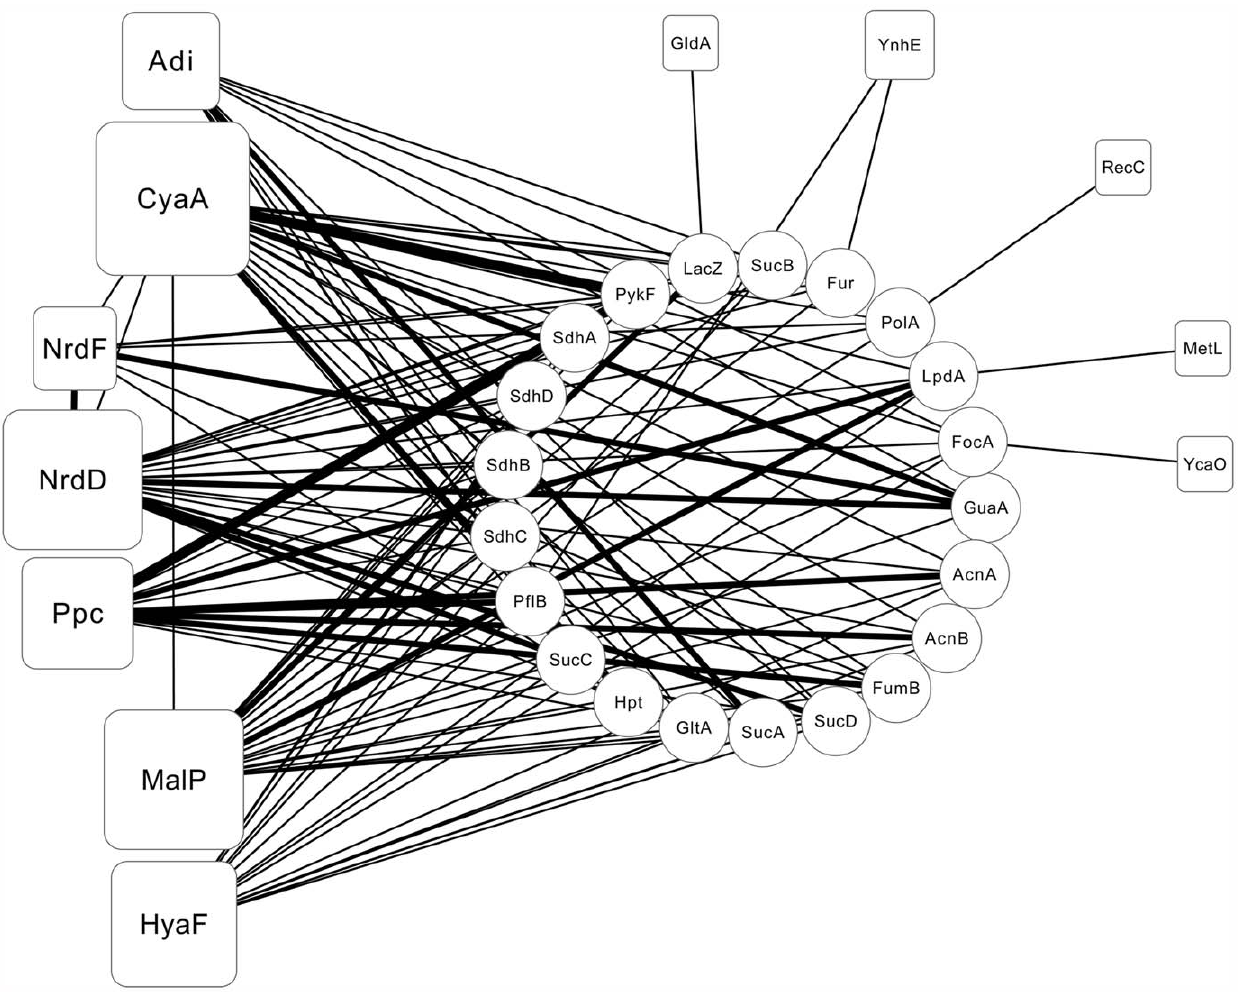
Figure 6. The functional interaction network of the 16 target proteins identified from the fluorescence polarization assays. Each square shape represents the target proteins identified from the FP assays, and round shapes represent the interacting proteins. The EcID was used to find the interacting proteins of these 16 targets. Here, we showed only the proteins that interact with at least 5 targets, and 21 interacting proteins were identified. The thicker line symbolizes that more databases show that they have an interaction between 2 proteins. Seven out of the 16 target proteins, NrdD, CyaA, MalP, Adi, NrdF, Ppc and HyaF, have more interactions and are considered to be hubs.